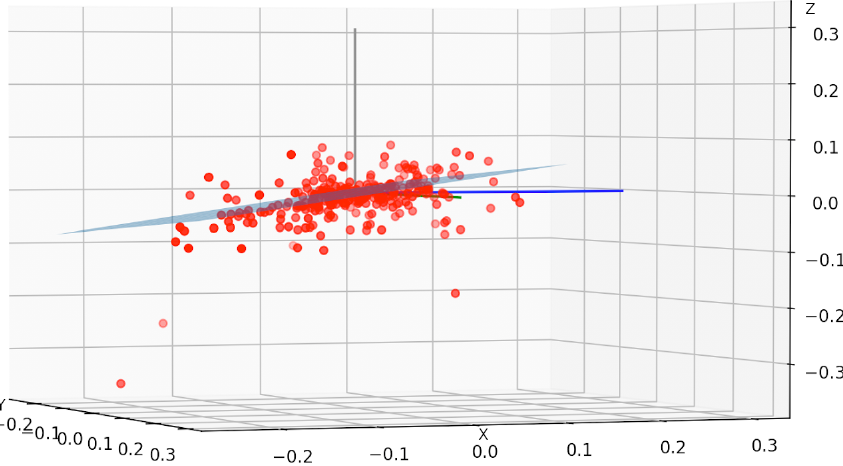
Figure 2. 3D distribution of acceleration points. The least squares plane is drawn in blue (side view)—values are in m/s 2